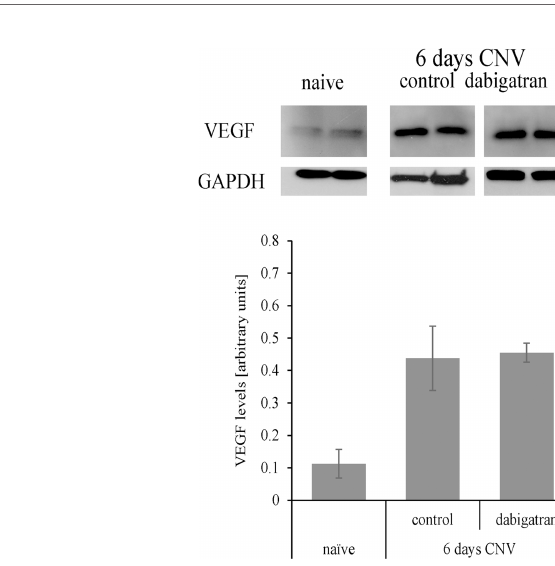
FIGURE 7 | Dabigatran affects VEGF expression in repair but not angiogenesis phase of CNV. Equal amounts of RPE/choroid extracts (15 m g/lane) were loaded per lane, probed with antibodies as indicated, and band intensities quanti fi ed. Arbitrary values were established based on normalization with GAPDH. Age-matched naive animals without CNV and fed normal mouse chow were compared to those in which CNV was and treated with dabigatran during the angiogenesis and repair phase of CNV. During the induction phase and repair phase of CNV, VEGF levels in the RPE/choroid were elevated; however, dabigatran only affected VEGF levels in the long-term paradigm.